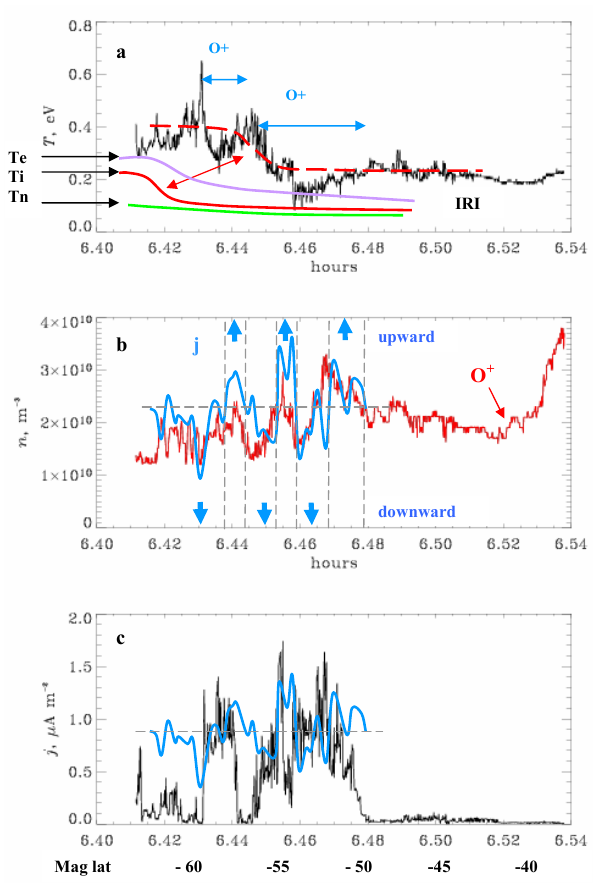
Fig. 6. Plasma parameters measured by the APR analyser during the same period as in Fig. 5, i.e. (a) O + temperature (in black), together with the electron (in violet), ion (in red) and neutral (in green) temperatures deduced from the IRI model; (b) O + density (in red), together with the current density (in blue), as deduced from the magnetic perturbations; (c) current density due to the electrons with energy higher than 12eV. Regions of O + outflow are indicated by horizontal arrows. The layers of anti-parallel currents are high- lighted by vertical dashed lines and the current direction is indicated by